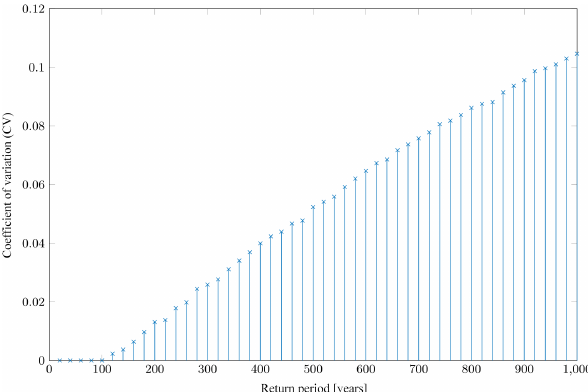
Figure 6. Coefficient of variation (CV) of ground motion predicted to be exceeded at various return periods for the Kalimantan Timur province (see Fig. 3). In this case, it is not possible to determine a range of return periods for which the CV remains in a stable range.